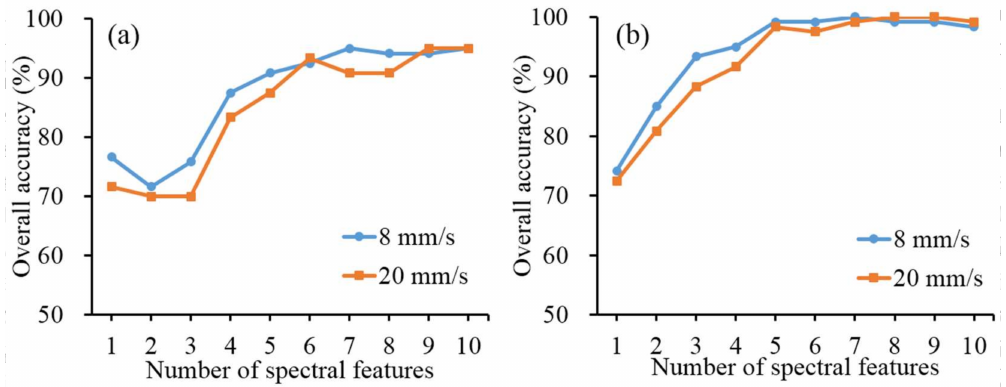
Figure 6. Two-class performance comparison based on spectral features at different scanning speeds and spectral resolutions of 1.25 nm ( a ) and 5.03 nm ( b ),